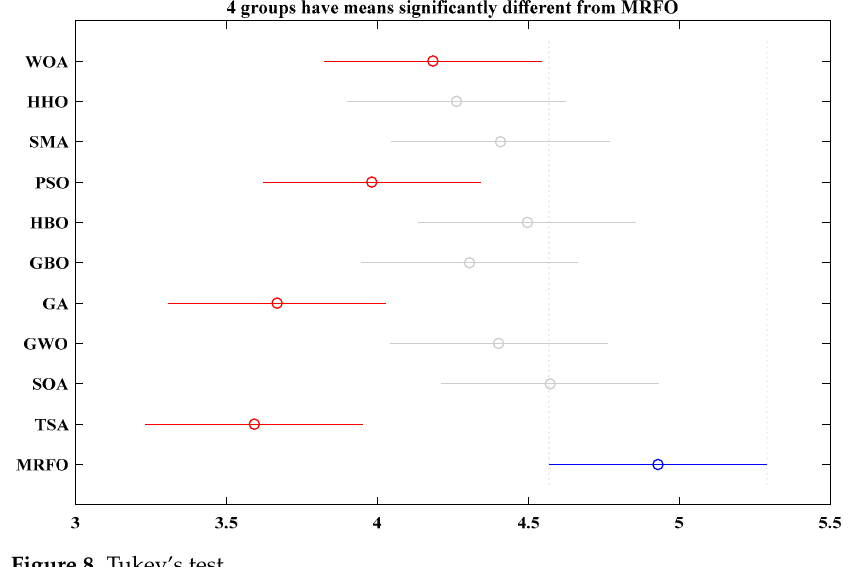
Figure 8. Tukey’s